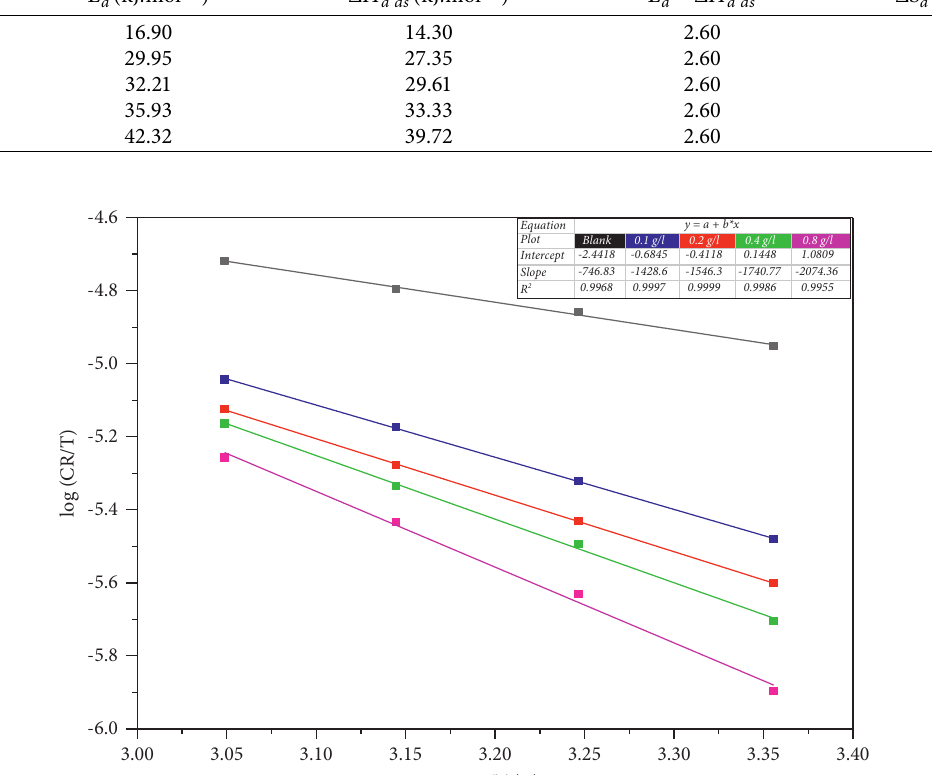
Figure 5: Carbon steel corrosion in 1M HCl in the absence and presence of EW and the Arrhenius plot of log (CR) versus 1000/T. The activation entropy ( Δ S ads ) and activation enthalpy ( Δ H ads ) are shown, and Arrhenius was used to achieve the results Table 4: Values for E H S a , Δ a ds , and Δ a ds in the absence of inhibitors and in the presence of inhibitors of varying doses. C ( g.L − 1 ) inh